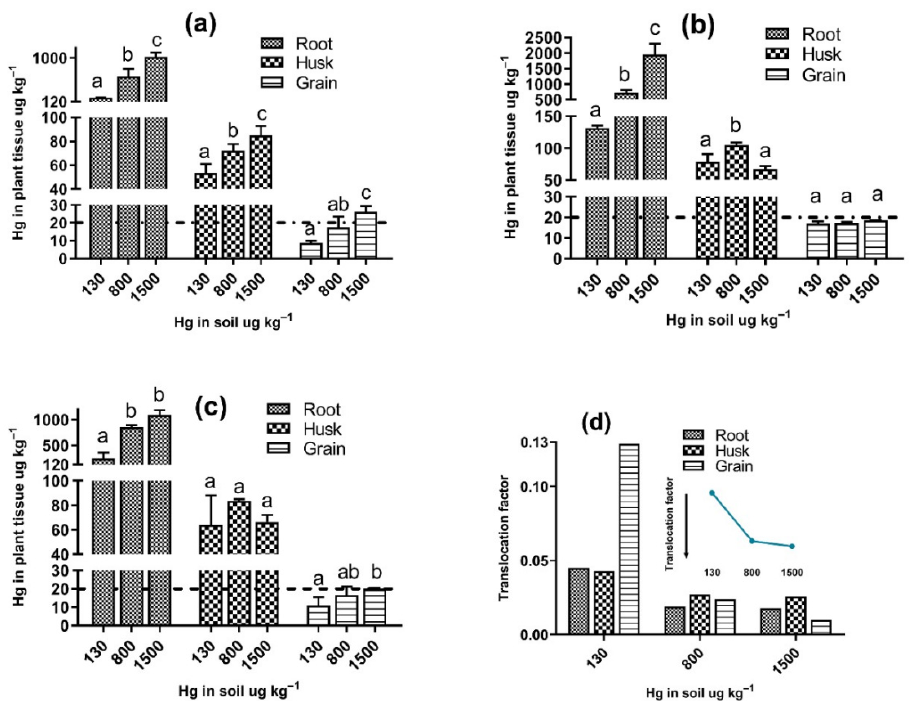
Figure 2. Concentrations of Hg ( µ g kg − 1 ) in the roots, husks, and grains of varieties ( a ) FA473, ( b ) FA2000, ( c ) FAM, and ( d ) Oryza sativa L.; translocation factors grown in soils with different Hg levels. Different letters indicate statistically significant differences ( α = 0.05). The dashed line at 20 µ g kg − 1 is the threshold established by the Chinese National standard [48].